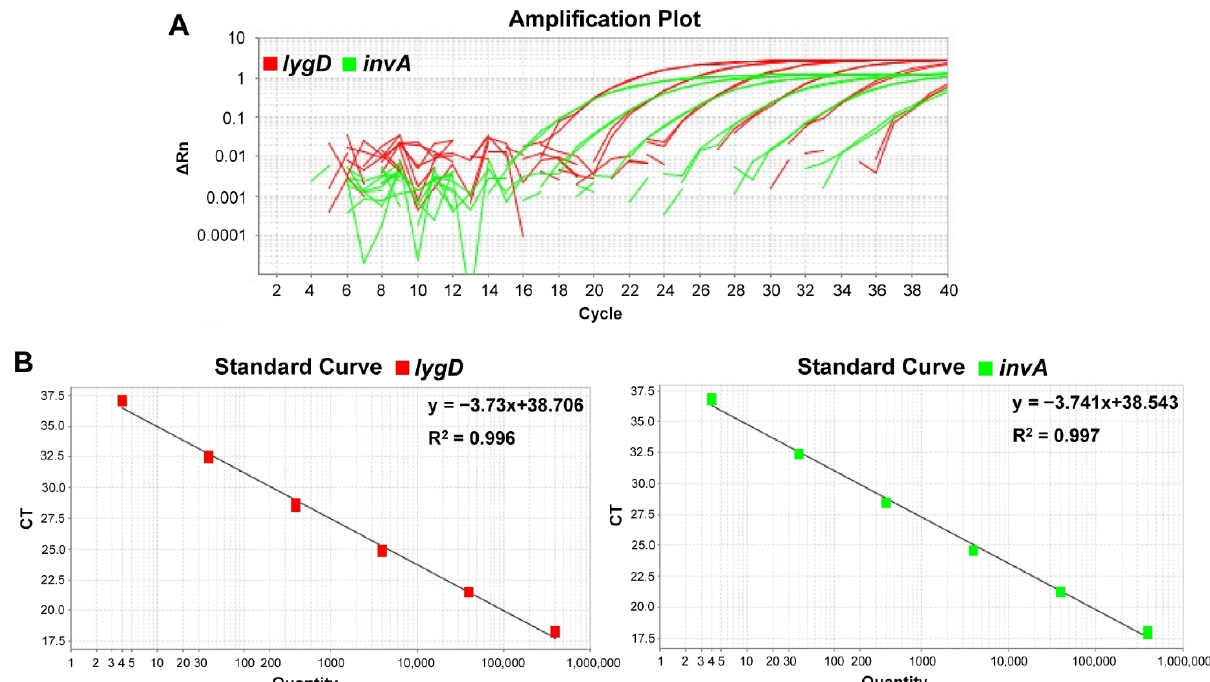
Figure 1. Sensitivity and standard curves of the developed duplex TaqMan real-time polymerase chain reaction (PCR) assay. The detection limit of the PCR assay was determined by testing various concentrations of Salmonella Enteritidis C50041 genomic DNA, ranging from 4–4 × 10 5 copies per reaction. The PCR system contained probes and primers specific for S. enteritidis and Salmonella spp. ( A ) Amplification plots of the duplex real-time PCR. X axis—PCR cycle numbers; y axis—fluorescence intensity. ( B ) Standard curves indicating the linearity for detecting lygD and invA by real-time PCR. There was a good linear correlation between the Ct values of lygD and invA and the logarithm of the DNA copy numbers over the whole range of DNA concentration. The Ct values were plotted against the corresponding Salmonella cell